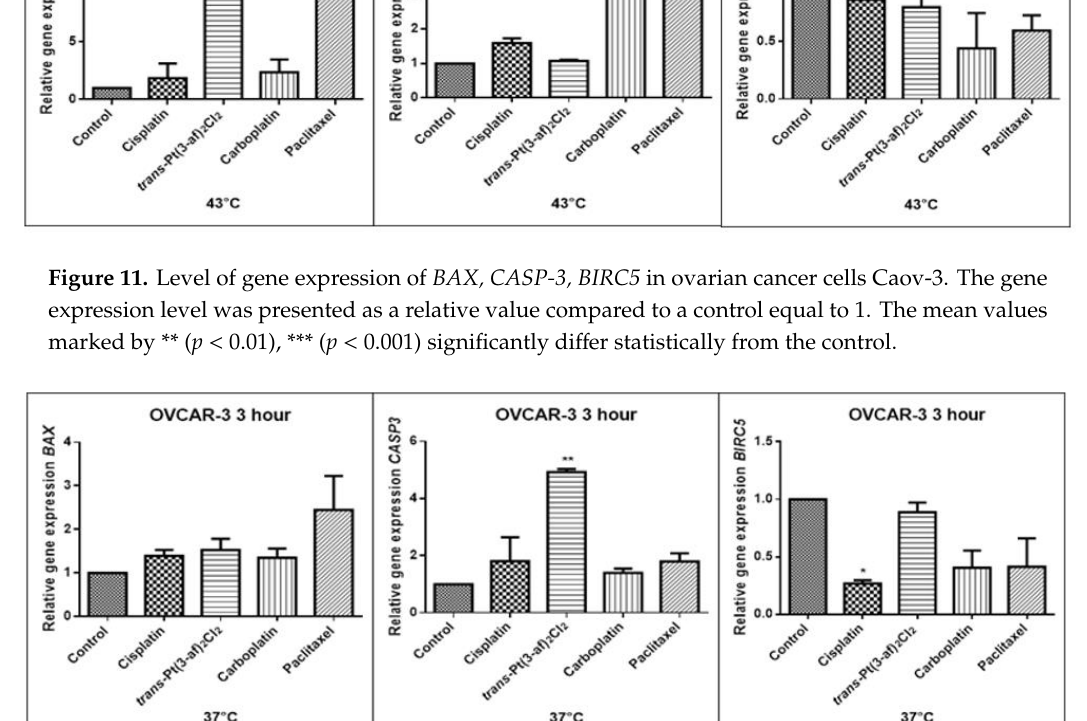
Figure 12. Level of gene expression of BAX, CASP-3, BIRC5 in ovarian cancer cells OVCAR-3. The gene Figure 12 . Level of gene expression of BAX, CASP-3, BIRC5 in ovarian cancer cells OVCAR-3. The expression level was presented as a relative value compared to a control equal to 1. The mean values gene expression level was presented as a relative value compared to a control equal to 1. The mean Figure 12 . Level of gene expression of BAX, CASP-3, BIRC5 in ovarian cancer cells OVCAR-3. The Figure 12 . Level of gene expression of BAX, CASP-3, BIRC5 in ovarian cancer cells OVCAR-3. The marked by * ( p < 0.05), ** ( p < 0.01), significantly di ff er statistically from the values marked by * ( p < 0.05), ** ( p < 0.01), significantly differ statistically from the control. gene expression level was presented as a relative value compared to a control equal to 1. The mean gene expression level was presented as a relative value compared to a control equal to 1. The mean values marked by * ( p < 0.05), ** ( p < 0.01), significantly differ statistically from the control. values marked by * ( p < 0.05), ** ( p < 0.01), significantly differ statistically from the control.